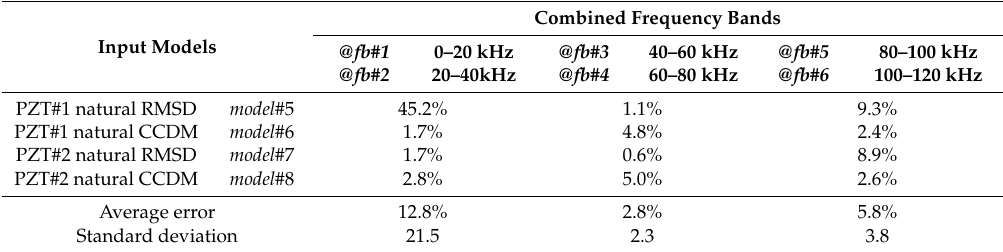
Table 5. Main characteristics of the ANN models in experimental test case